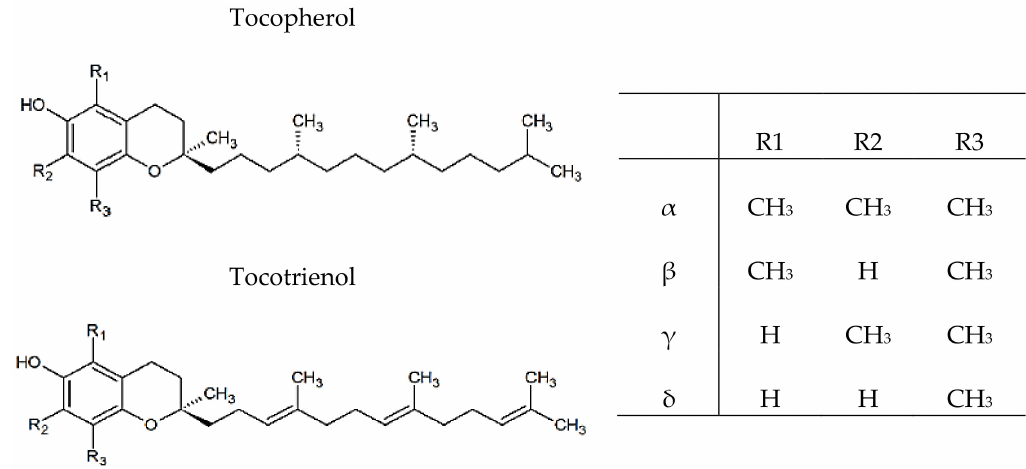
Figure 5. Chemical structures of tocopherols and tocotrienols.